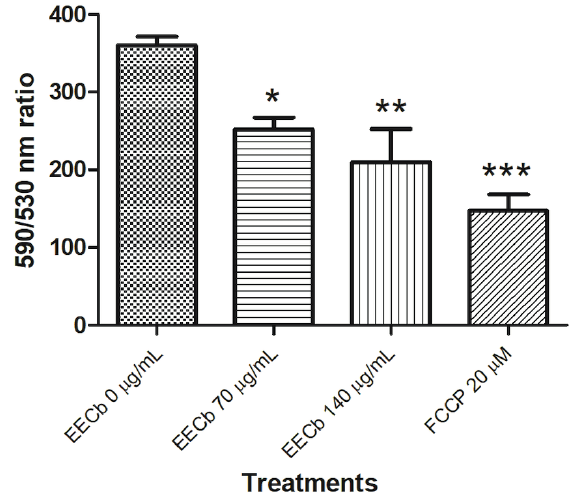
Figure 5. The effect of EECb on mitochondrial membrane potential (ΔΨm) in Leishmania amazonensis. L. amazonensis promastigotes were cultivated in Schneider’s insec t medium in the absence or presence of 70.0 µg/mL or 140.0µg/ mL EECb for 24 h. Positive control was treated with FCCP (20 µM) for 20 min, and in the negative control (absence of EECb), the same volume of vehicle (DMSO) was added to the growth medium. Dose-dependent alterations in relative ΔΨm values are expressed as the ratio of the JC-1 fl uorescence measurements at 590 nm (for J-aggregate) versus 530 nm (for J-monomer). Data are expressed as the means ± standard errors of three different experiments. Signifi cant differences, relative to the control group, are indicated by * (p<0.05), ** (p<0.01), and ***